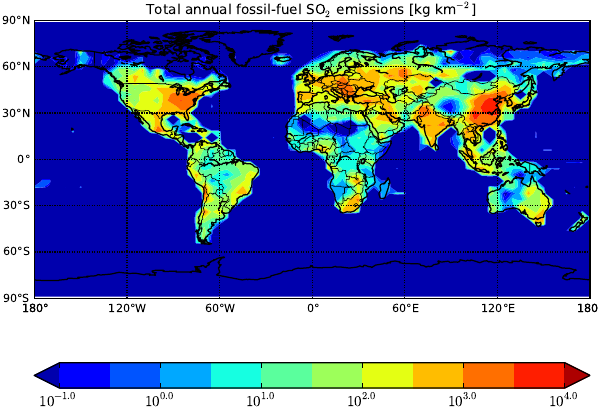
Figure 1. Total annual fossil-fuel SO 2 emissions in kgkm − 2 used for this study, excluding shipping